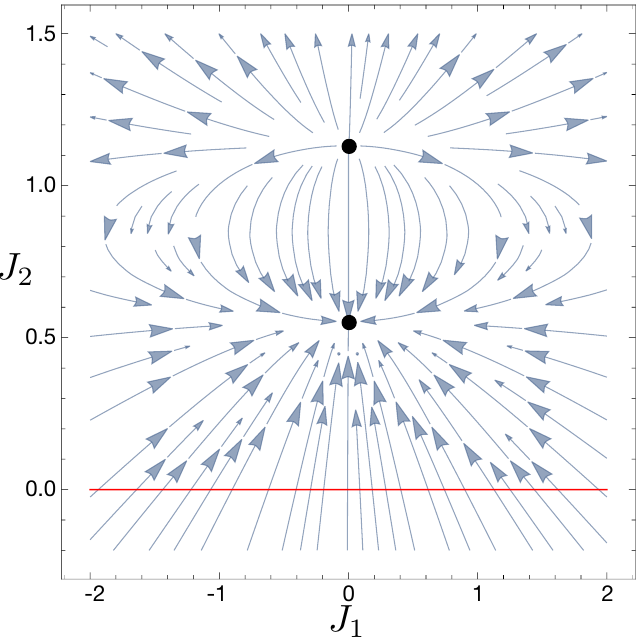
Figure 1: RG flow of a toy model considered in Sec. 5.1. J ( J ) is the single-trace 1 2 = 0 subspace, which is denoted as (double-trace) coupling. The β -functions in the J 2 the red horizontal line, fix the full β -functions in the space of J and J . The full β - 1 2 functions exhibit rich structures that include one stable and one unstable fixed points away from the single-trace subspace, which are fully encoded in the β -functions = within the subspace of J 2